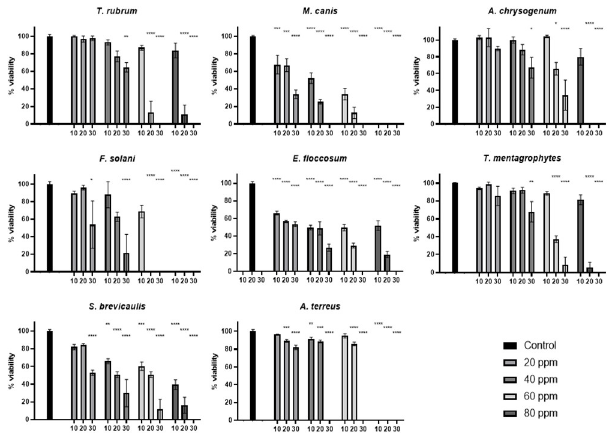
Fig 3. Percentage of viability for each of the eight fungal species with ozone treatments (20 ppm, 40 ppm, 60 ppm and 80 ppm) at three different times (10 min, 20 min and 30 min). Statistical significant results are shown in comparison with the absolute control and indicated with